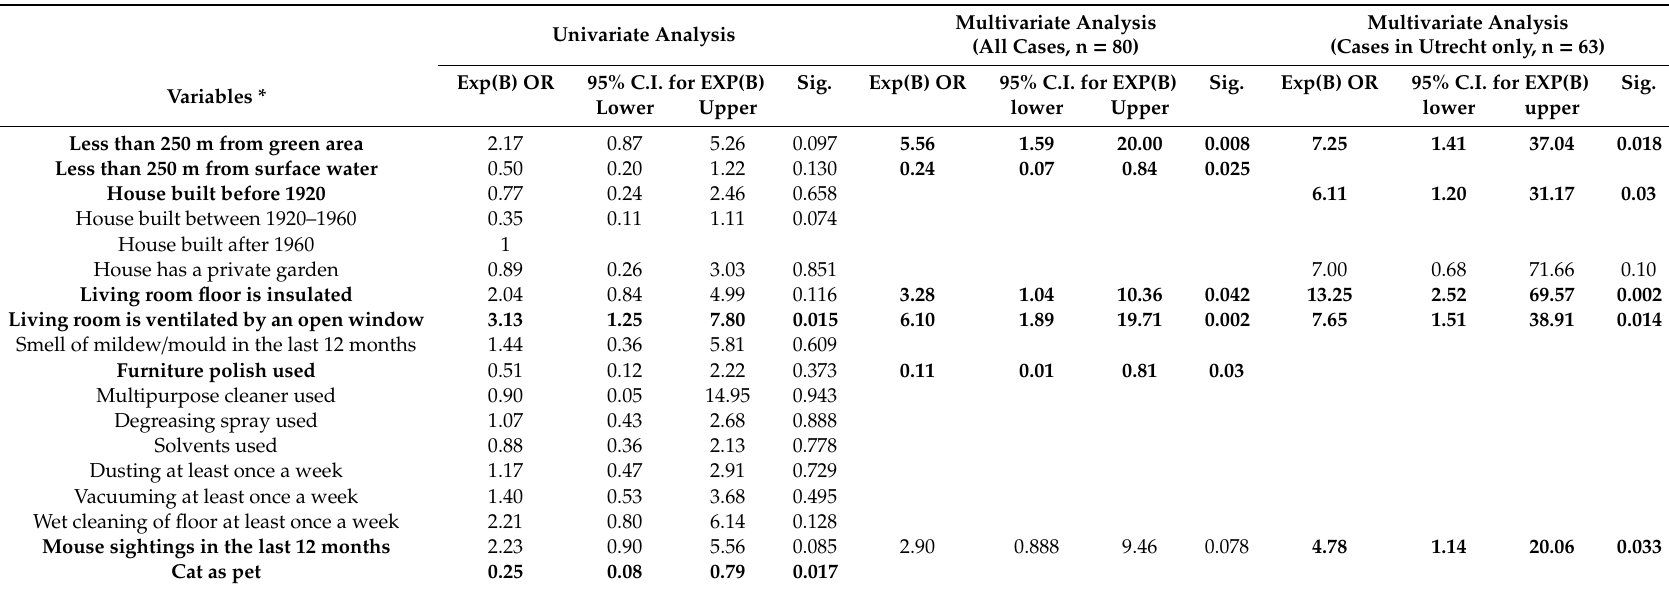
Table 3. Logistic regression for predictors of Mus m 1 allergen detection in 80 Dutch households. Univariate Analysis